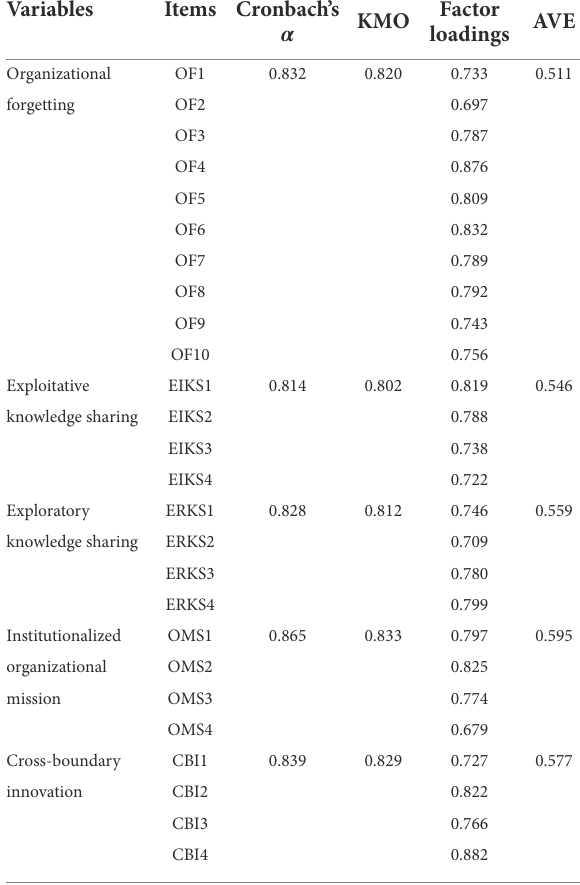
TABLE 2 Confirmatory factor analysis. TABLE 3 Results of reliability and validity